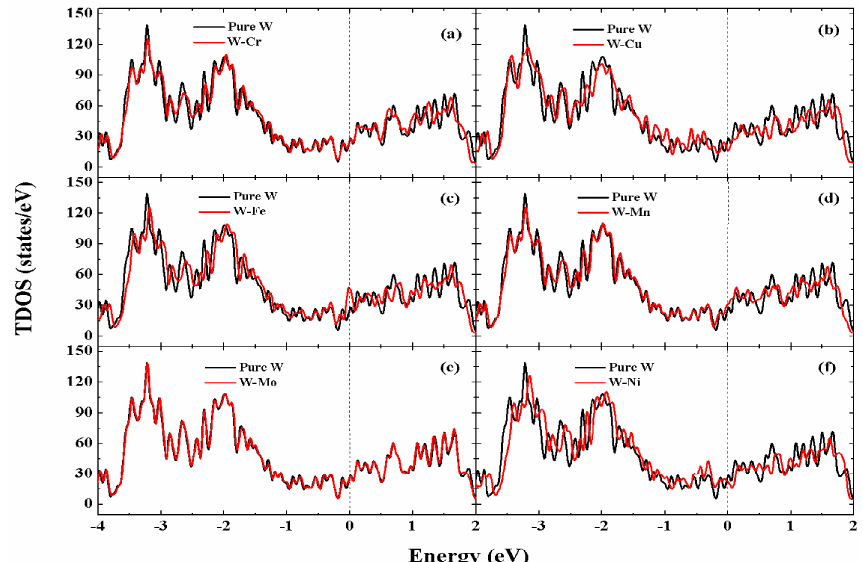
Figure 6. The total density of states (TDOS) of pure W and the W-TM (TM = Cr, Cu, Fe, Mn, Mo and Ni, respectively) alloys. The energy is with respect to the Fermi level.